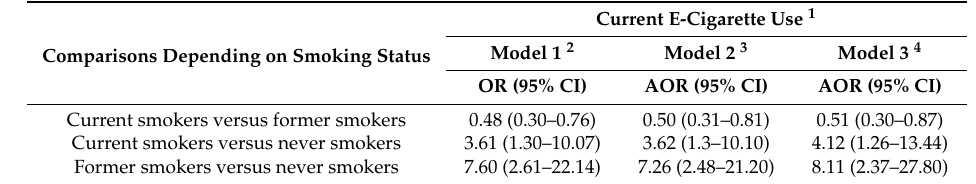
Table 3. Associations between the e-cigarette use and smoking